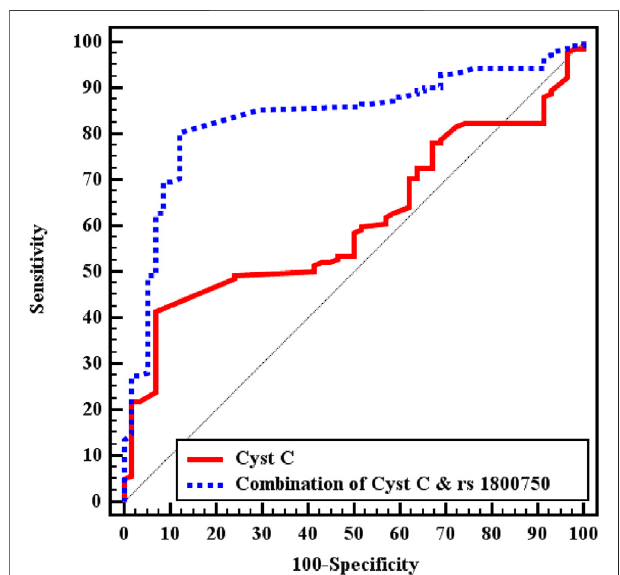
FIGURE1| ROCcurveanalysisfor CystCtodiscriminateS-AKIpatients (No. (cid:1) 142) from non-AKI (No. (cid:1) 58) in total